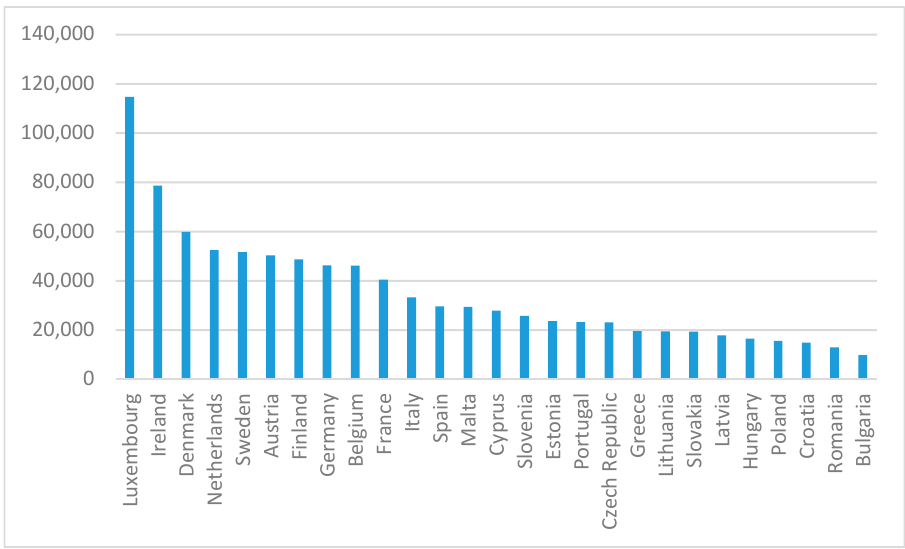
Figure 5. GDP per capita (current USD) in European Union countries, 2019. Source: Authors’ procedure based on World Bank Data.